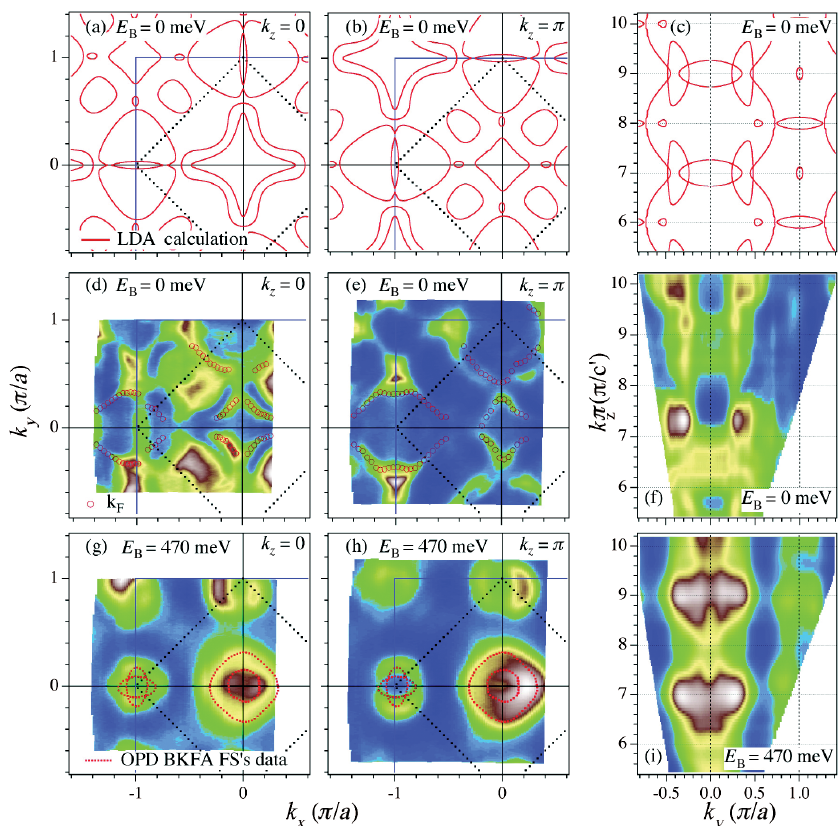
FIG. 3. (a),(b) LDA cuts of the FS at k z ¼ 0 and k z ¼ (cid:1) , respectively. (c) LDA FS in the plane defined by k y ¼ 0 . (d)–(f) Experimental FS mappings corresponding to the cases described in panels (a)–(c). The open symbols represent extracted FS data. (g)–(i) Same as (d)–(f) but for ARPES data recorded 470 meV below E F . The ARPES FS data [18] for Ba 0 : 6 K 0 : 4 Fe 2 As 2 (red dashed lines) are plotted in (g),(h) for